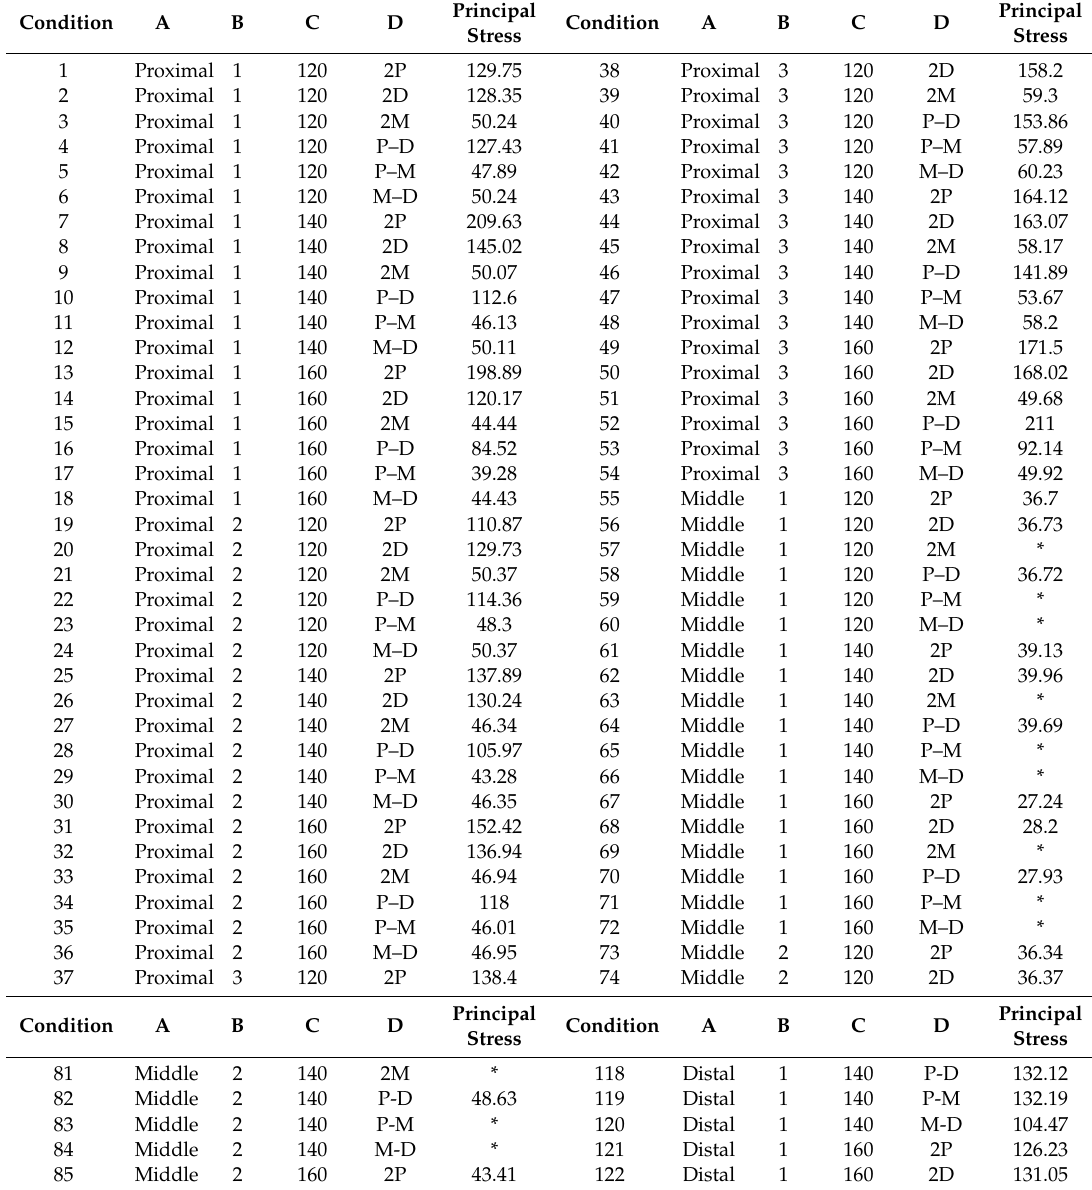
Table 7. FEA model of the two locking screws’ results for the testing